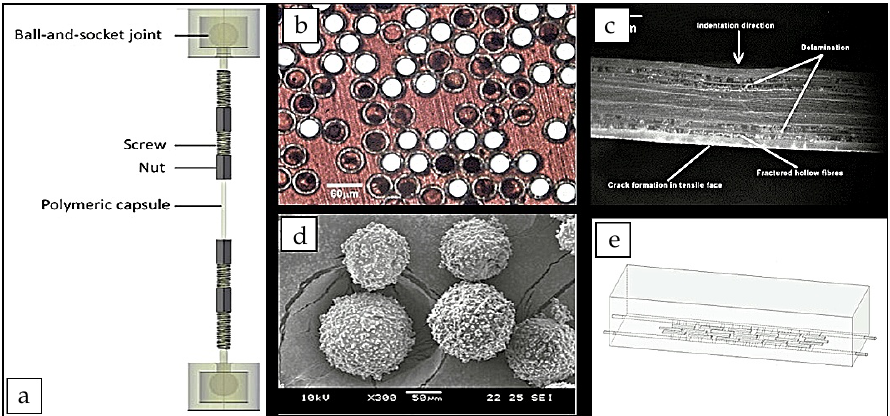
Figure 5. Self-healing mechanism based on adhesive agents. ( a ) Test setup used to determine the tensile strength of laboratory-scale hollow glass tubes with an outer hole of diameter 5 mm and an inner pin of diameter 3 mm. Reproduced with permission from the authors of [117]. Copyright 2015, Elsevier. ( b ) Hollow glass fibres of 60 µ m external diameter with a hollowness of 50%. ( c )